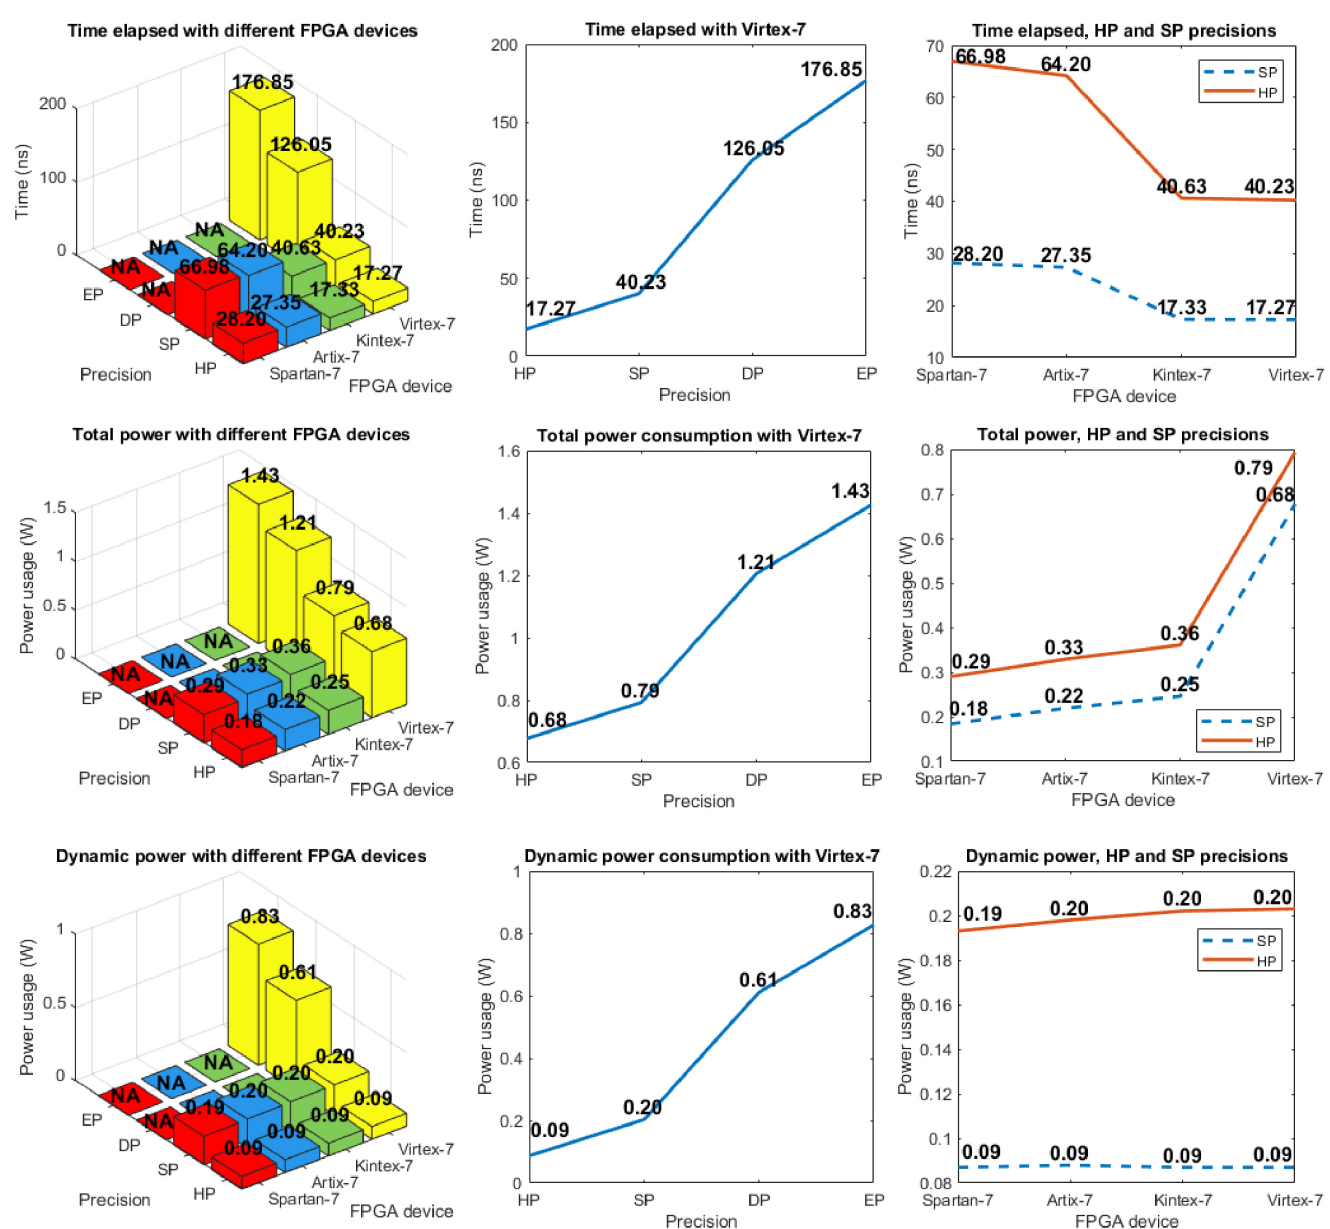
Fig 5. (left) Time, total power, and dynamic power used with different FPGA devices and precision levels (these are presented in inverse order for better visualization); (center) Similar analysis with Virtex-7 FPGA with different precision levels; (right) Similar analysis for the comparison of precision with HP and SP using different FPGA